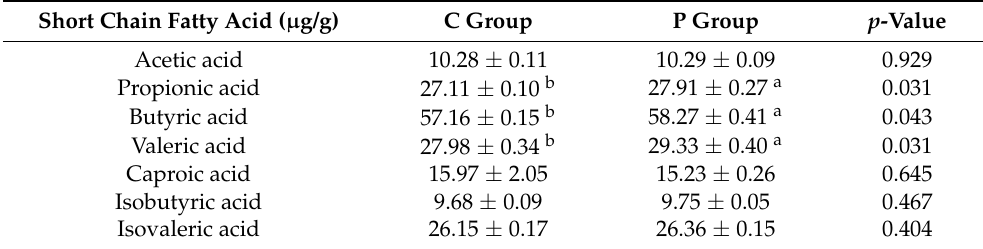
Table 3. Effect of probiotics on colon short-chain fatty acids (mg/100 g).